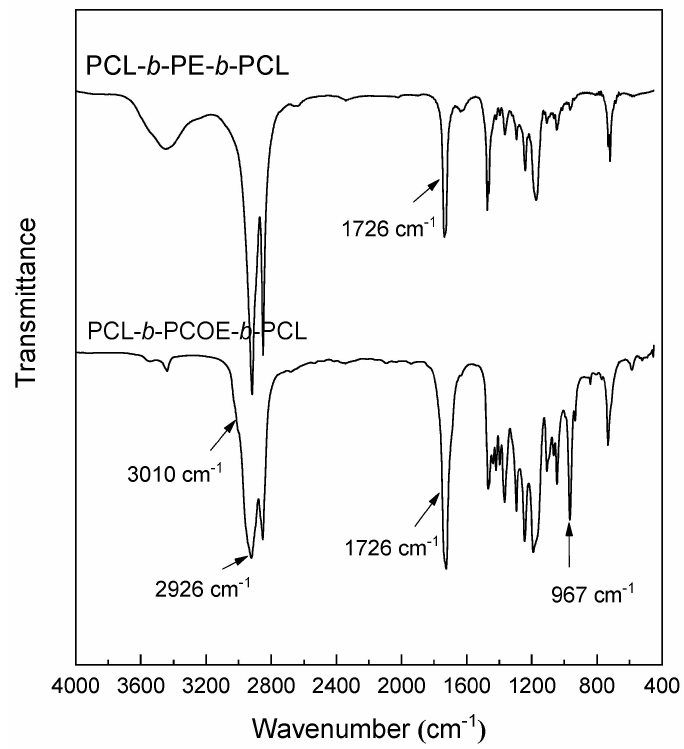
Figure 1. FTIR spectra of triblock copolymers.